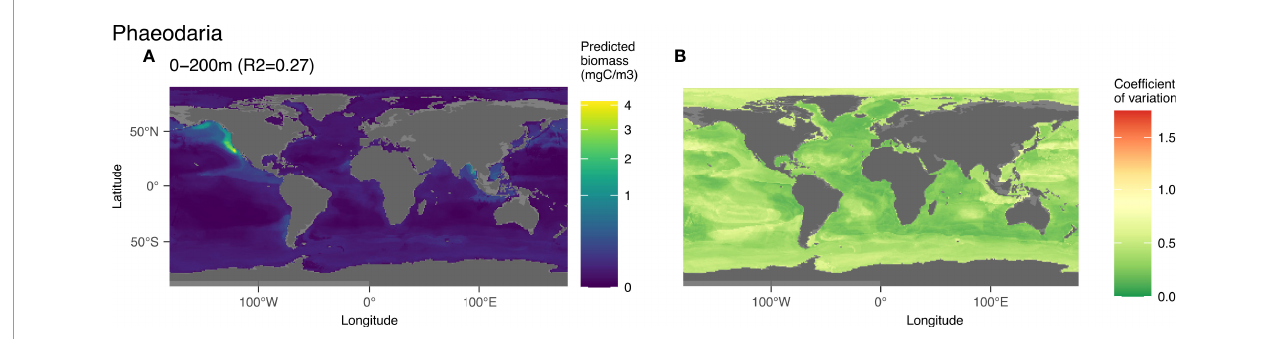
FIGURE 8 | Map of the mean biomass (color scale is log-transformed) of Phaeodaria as predicted by the model on 0-200 m (A) , as well as the coef fi cient of variation for the 0-200 m model (B) . In the map of predicted biomass, 12 cells in the California upwelling presented a value between 3 and 6 mgC m -3 and were represented here in yellow to observe the distribution of this group on a global scale. The color scale for the coef fi cient of variation has the same range for Figures 5 – 9